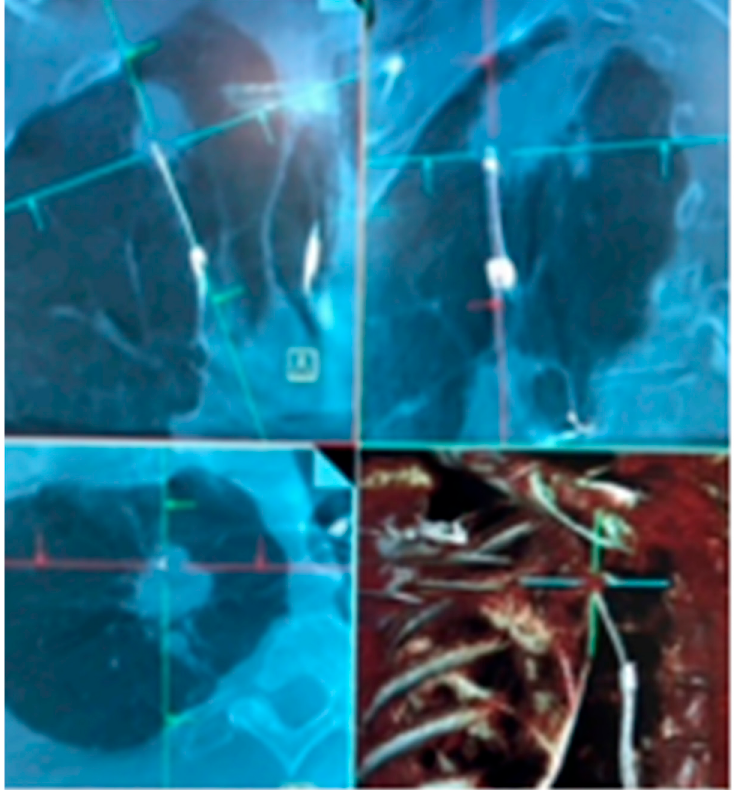
Figure 5. Cios Spin ® (Siemens Medical Solutions) mobile 3D C-arm imaging during Flexible Bron- choscopy (Olympus BF-P190) demonstrating tool in lesion confirmation prior to sampling. Reprinted with permission from AME publishing company [21].